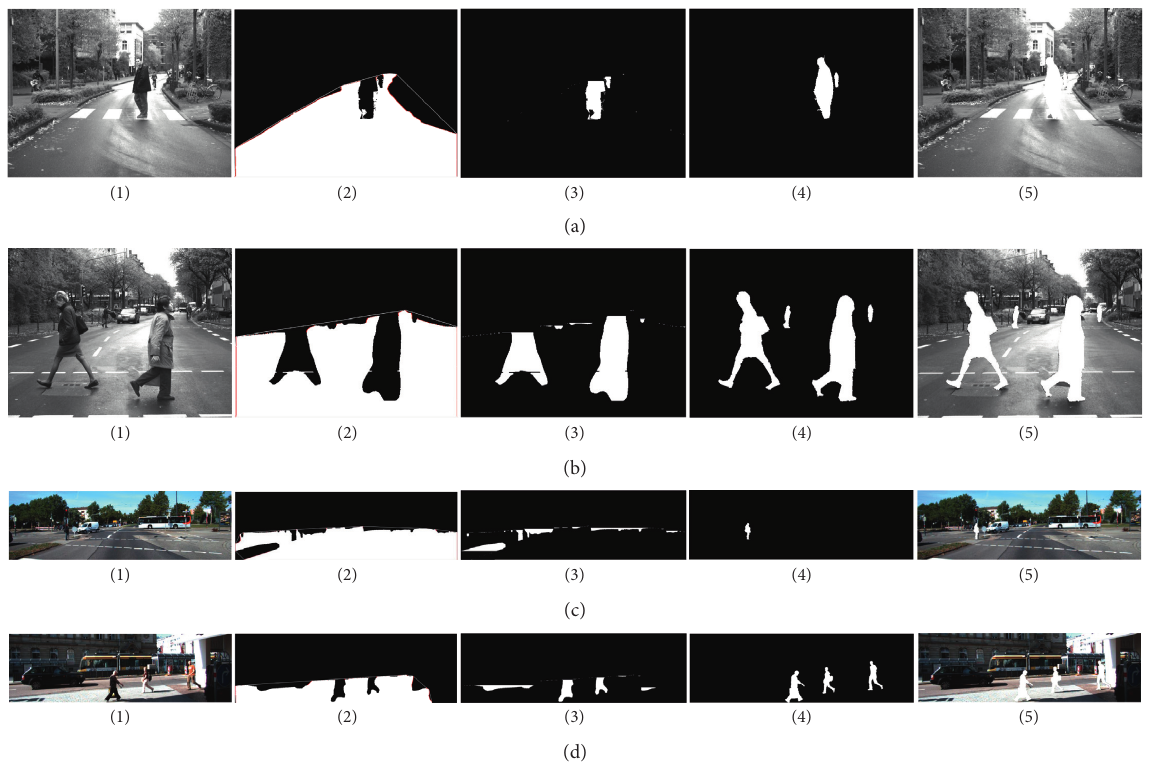
Figure 12: Typical pedestrian detection result on the road. (1) Original image (left). (2) Region of interest. (3) Pedestrian source point. (4) Pedestrian detection result. (5) Comparison.